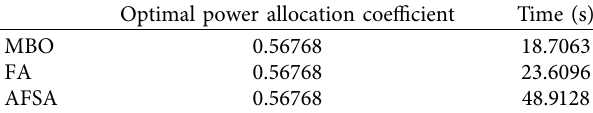
Table 4: Power allocation optimization comparison.